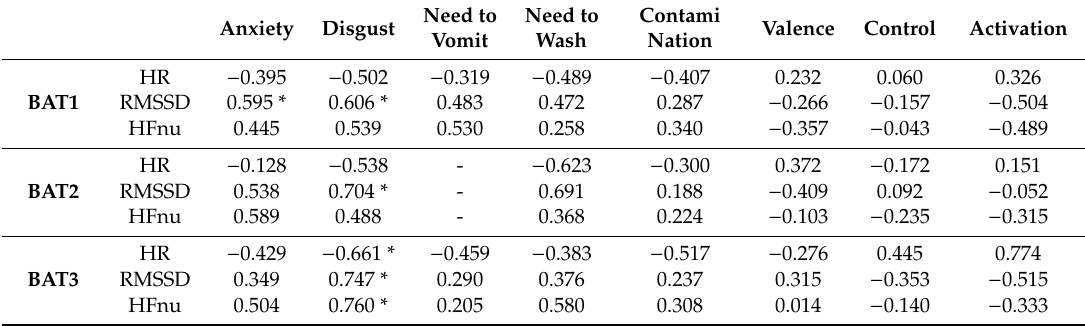
Table 2. Pearson correlation coe ffi cients in control group during the BAT (Behavioral Avoidance